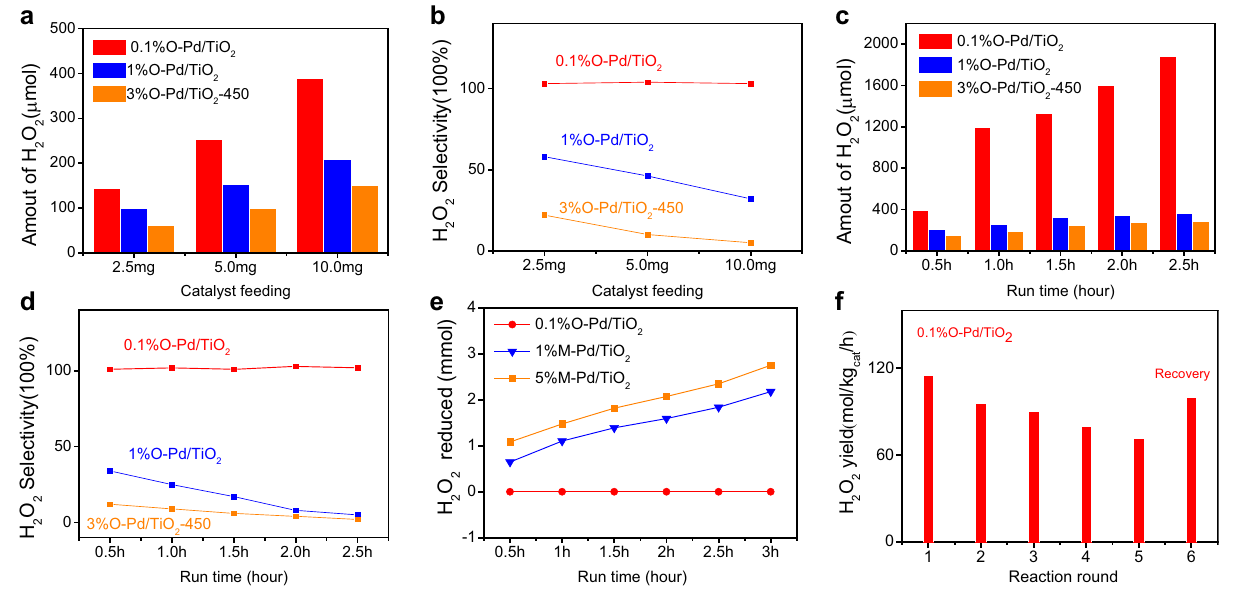
Fig. 4 | Catalytic performance.a , b The amounts of H 2 O 2 and the H 2 O 2 selectivity of differentcatalystsfeeding.Reactiontime:30min. c , d The amountsofH 2 O 2 and the H 2 O 2 selectivity of different reaction time. Catalyst feeding: 10mg. e H 2 O 2 degradationtest.Reactionconditions:5%H 2 /CO 2